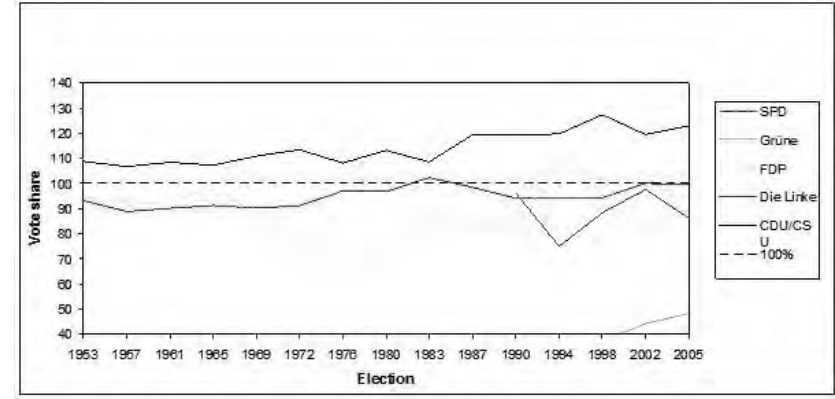
Figure 1: Old-age conservatism? Party vote shares in German federal elections (share among 60+ as a percentage of total vote share)